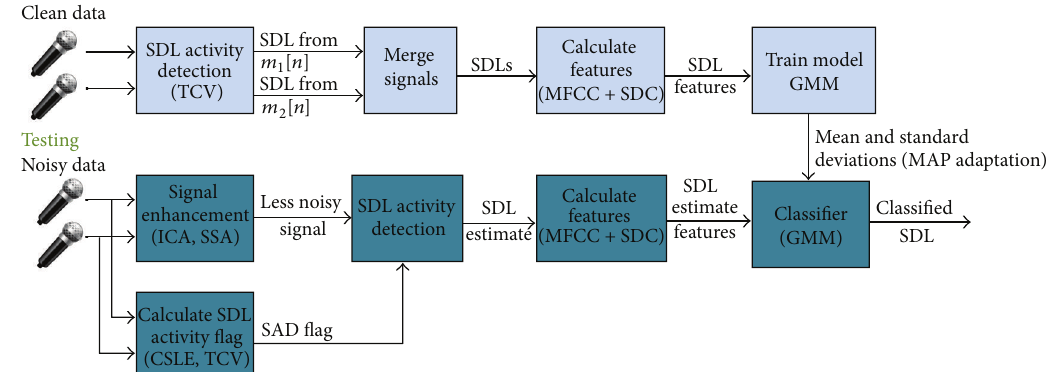
Figure 2: Proposed configuration for a robust “sounds of daily life” classification system, based on multiple